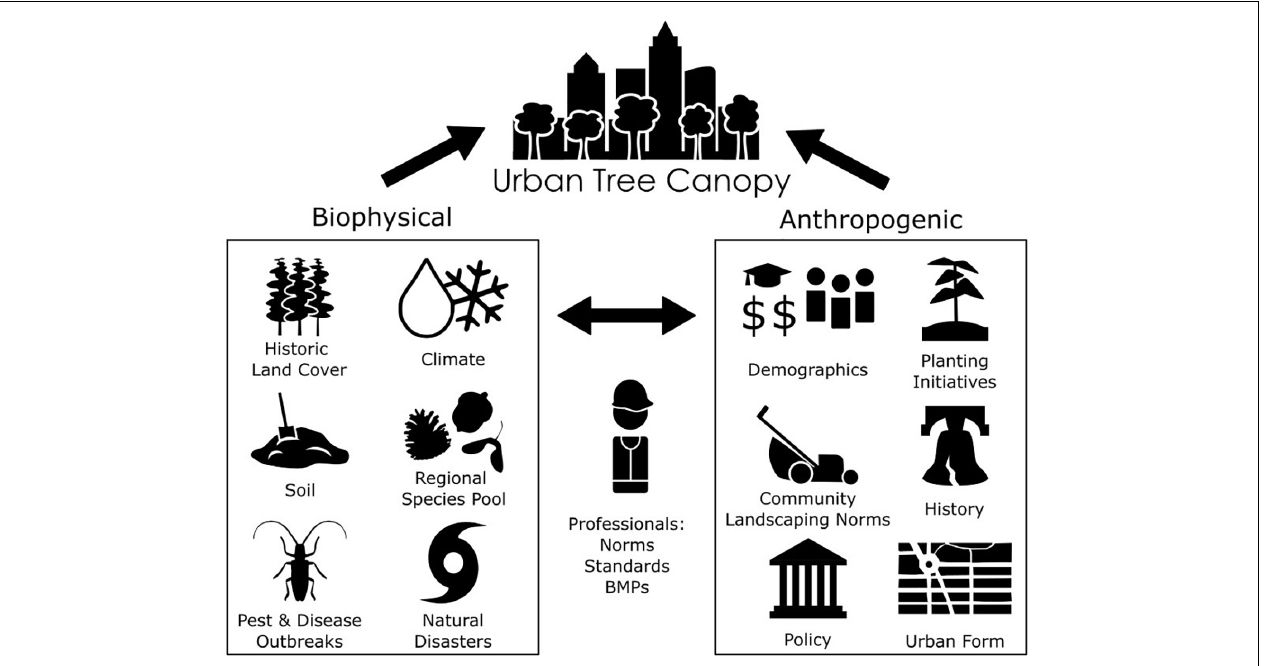
FIGURE 1 | Biophysical and anthropogenic factors that influence urban tree canopy